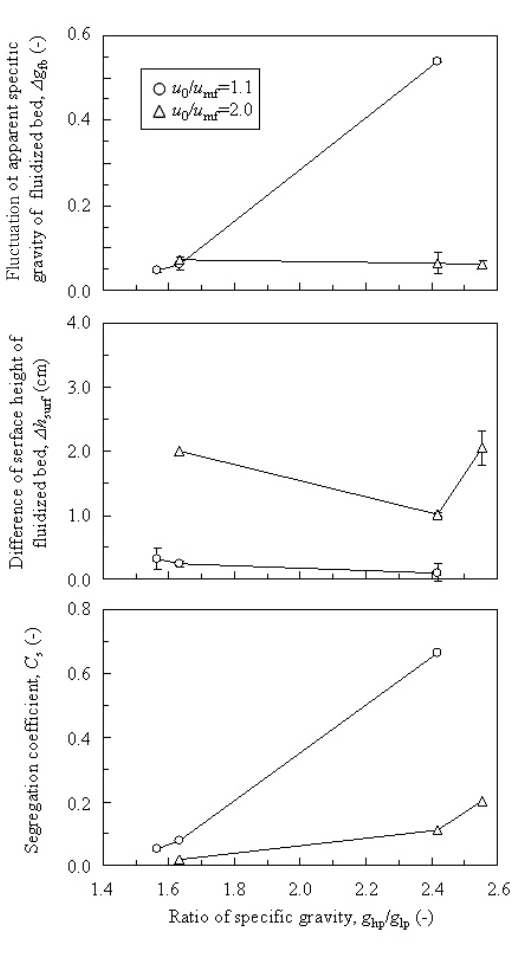
Fig.6 Fluctuation of apparent specific gravity, surface height of fluidized bed and segregation coefficient plotted against ratio of specific